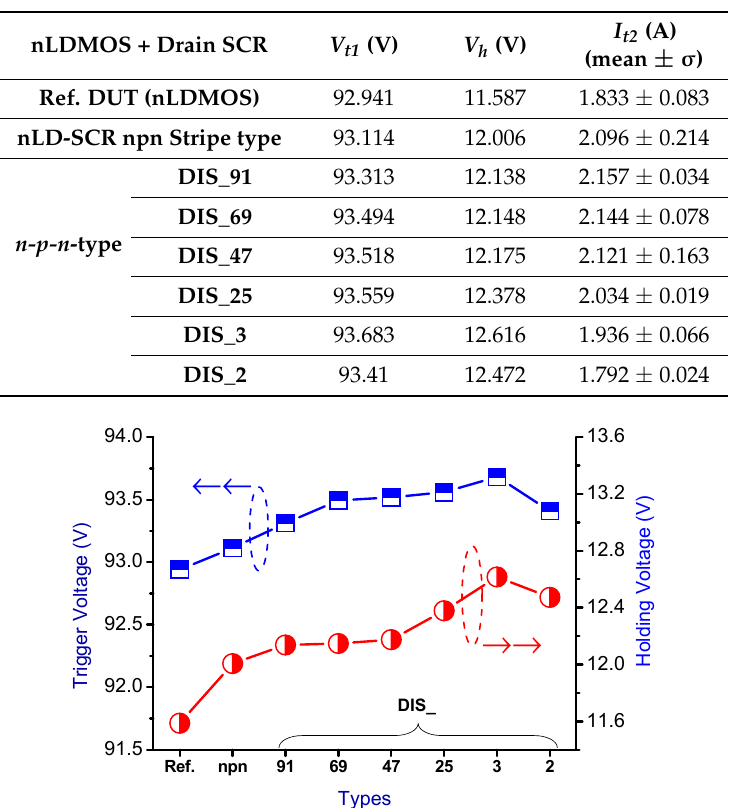
Figure 6. V t1 and V h diagrams of the nLDMOS-SCR ( n-p-n -arranged) tested samples.